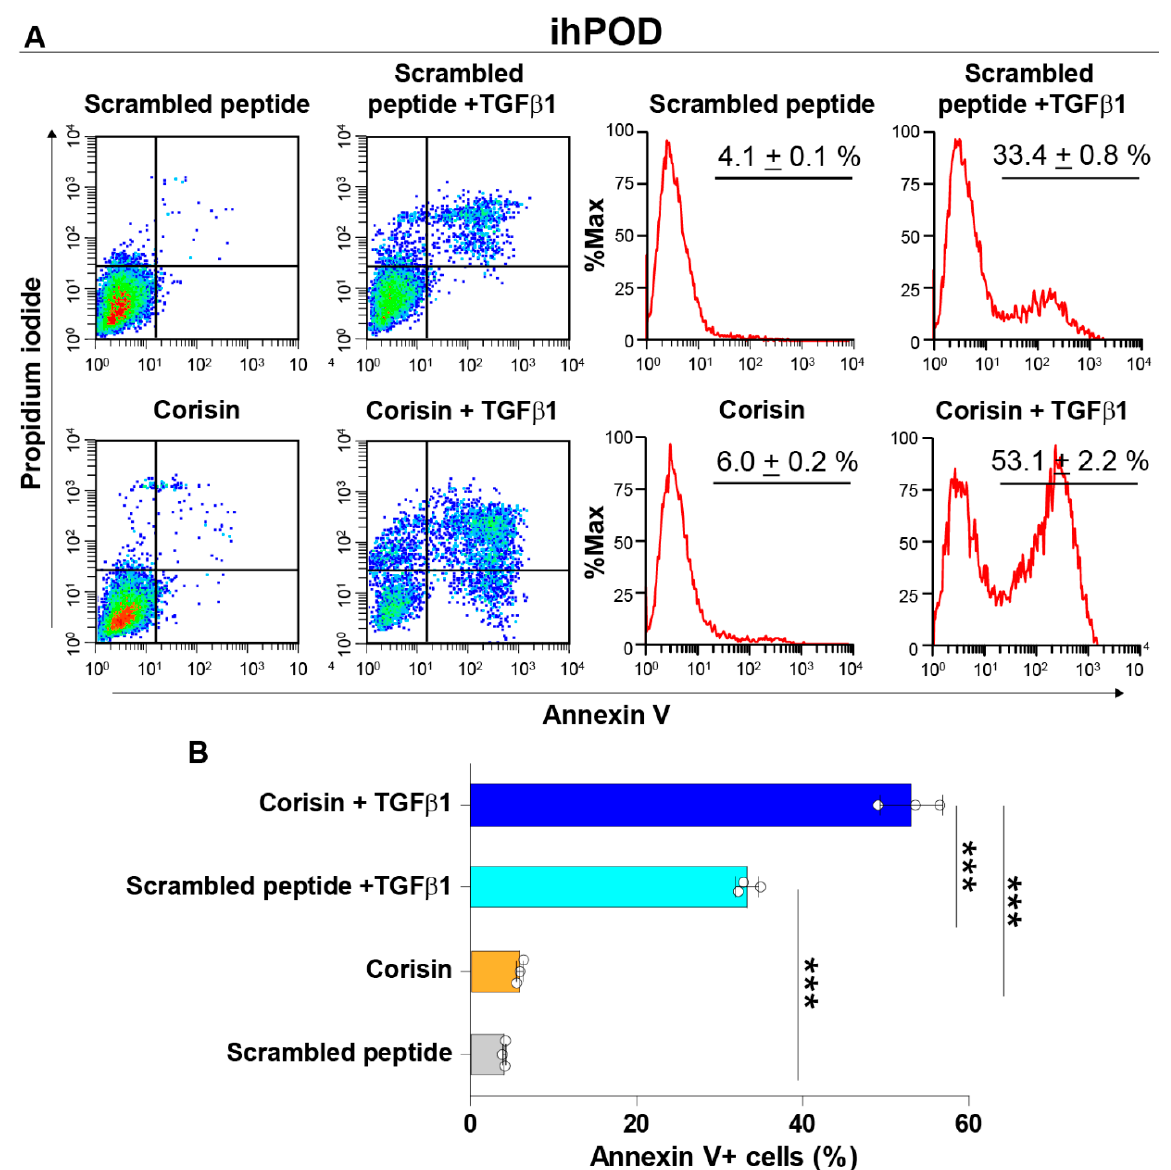
Figure 5. Corisin potentiates the proapoptotic activity of transforming growth factor- β 1 synergistically. Podocytes were cultured in the presence of scrambled peptide alone, corisin alone, or TGF β 1 in combination with scrambled peptide or corisin for 48 h and the degree of apoptosis was evaluated by flow cytometry ( A ). The number of cells was expressed in percentage ( B ). Data are expressed as the mean ± S.D. Statistical analysis by ANOVA with Newman-Keuls' test. *** p < 0.001.